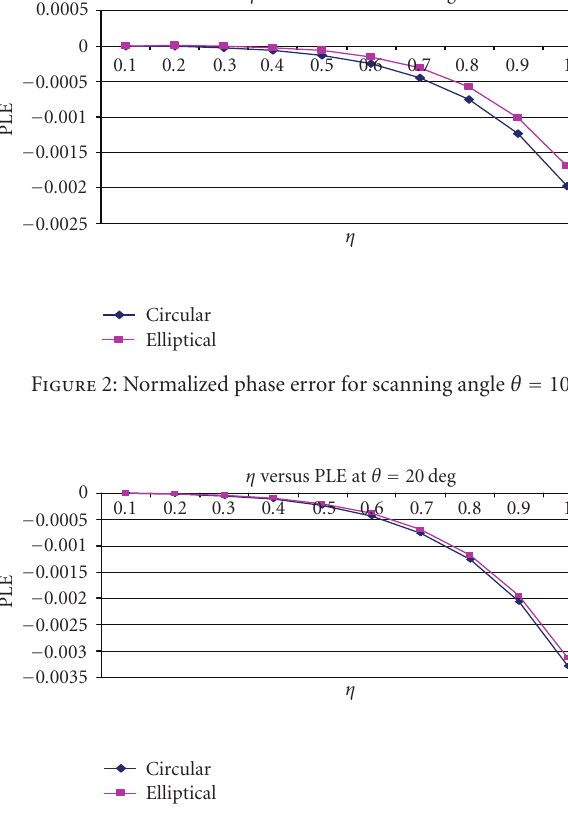
Figure 3: Normalized phase error for scanning angle θ =